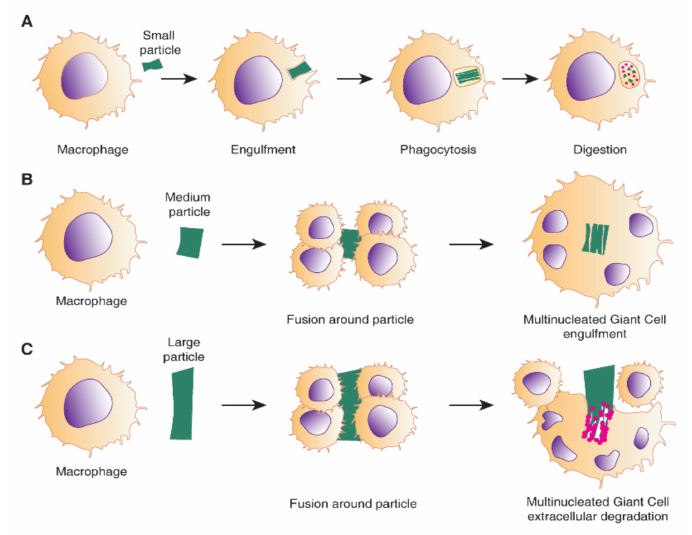
Figure 7. Schematic showing formation of foreign body giant cells (FBGCs) . Macrophages re- spond to foreign bodies in the host by ( A ) phagocytosis. However, when the particle is larger than a single macrophage, ( B ) they fuse to form multinucleated FBGCs around the particle, fully encapsu- lating it. ( C ) When the particle is much larger than an FBGC, multiple FBGCs attempt to fuse around the foreign particle to render extracellular degradation. Reproduced with permission from